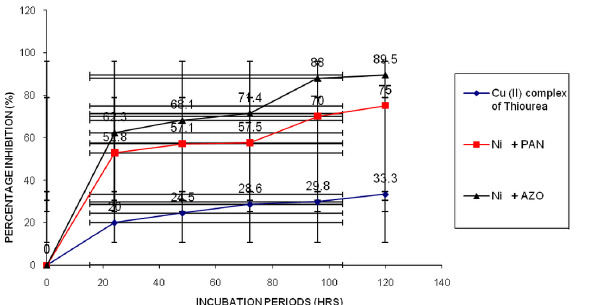
Fig. 5. Reduction of Mycelial growth of Collectotrichum capsici at 1.0 mg/ml concentration